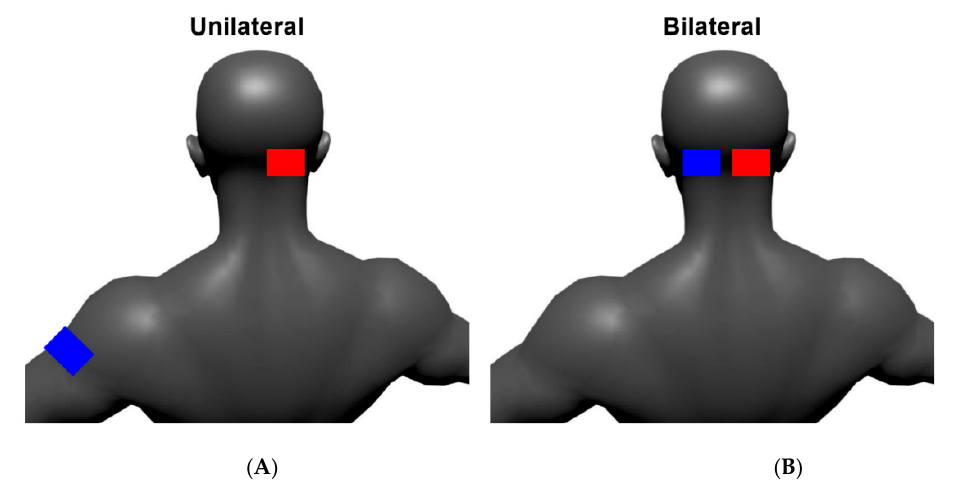
Figure 1. Anode (red) and cathode (blue) electrode configurations for the unilateral ( A ) and bilateral ( B ) montages.